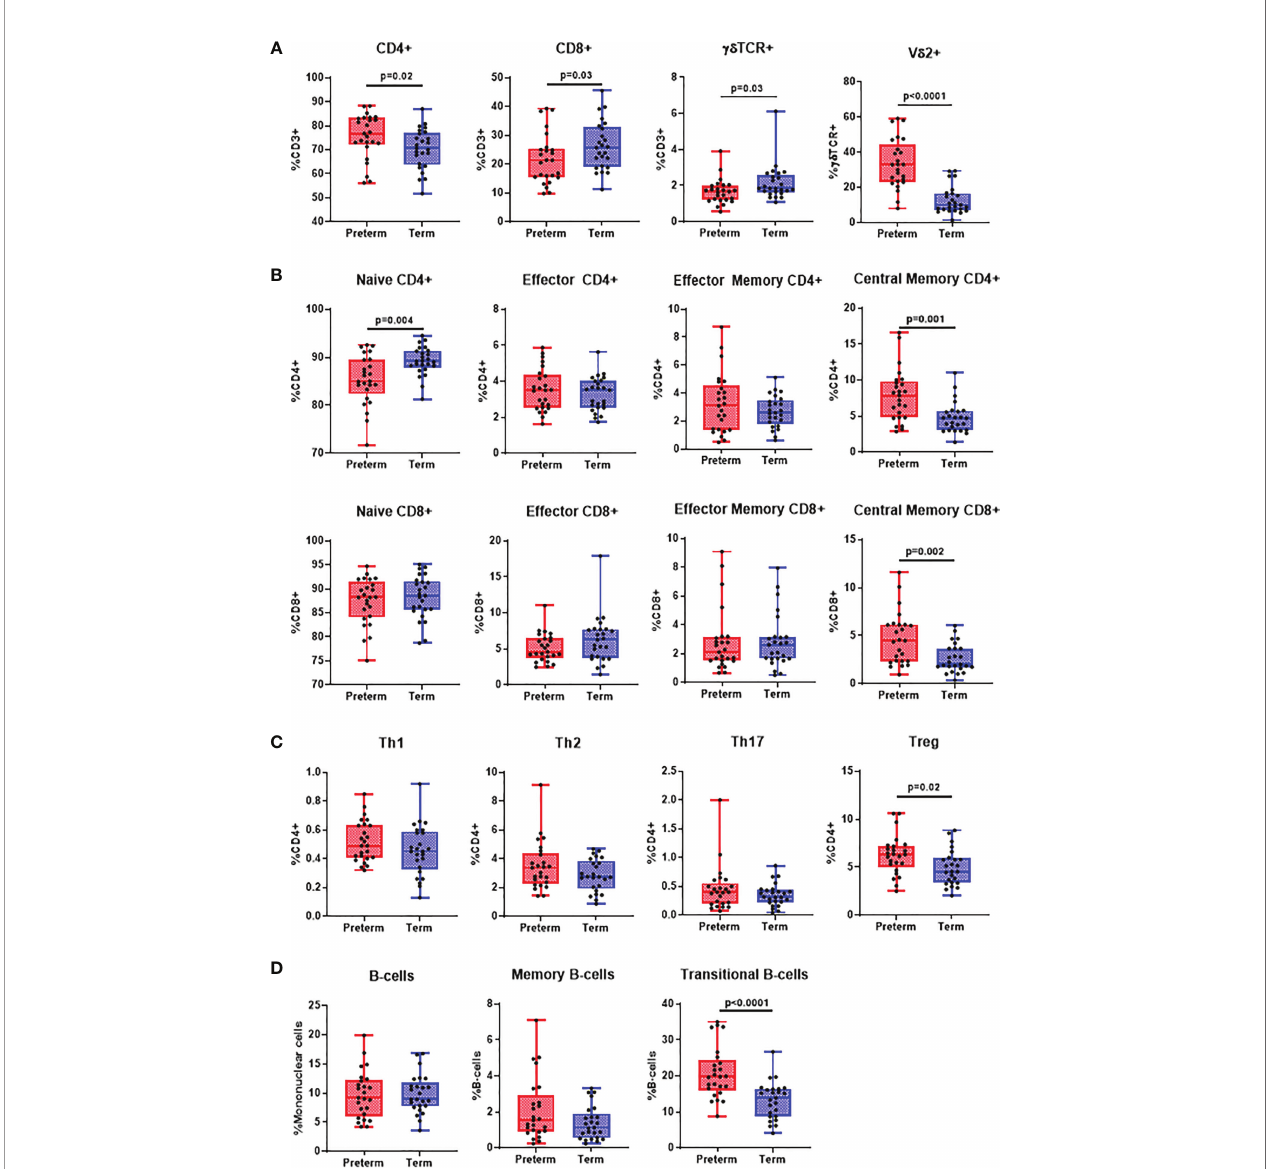
FIGURE 2 | Differences in adaptive immune cell populations in preterm and term infants. Flow cytometry was performed on cord blood mononuclear cells from 25 preterm and 25 term infants. All data was presented as a median +/- IQR with min-max whiskers. (A) General T-cell subsets CD4+ CD8+ and gd T-cells were expressed as % of CD3+ cells, whilst V d 2+ was expressed as % of gd T-cells. (B) Memory CD4+ and CD8+ T-cells were categorised into naïve, effector, central memory or effector memory and expressed as % of CD4+ or CD8+ T-cells. (C) CD4+ subsets were categorised as Th1, Th2, Th17 and Treg and expressed as % of CD4+ T-cells. (D) Total and memory B-cell subsets were expressed as % of mononuclear cells whilst IgD+ memory B-cells was expressed as % of memory B-cells and transitional B-cells were expressed as % of total B-cells. A Mann-Whitney U-test was performed for all analysis and a p<0.05 was considered signi fi